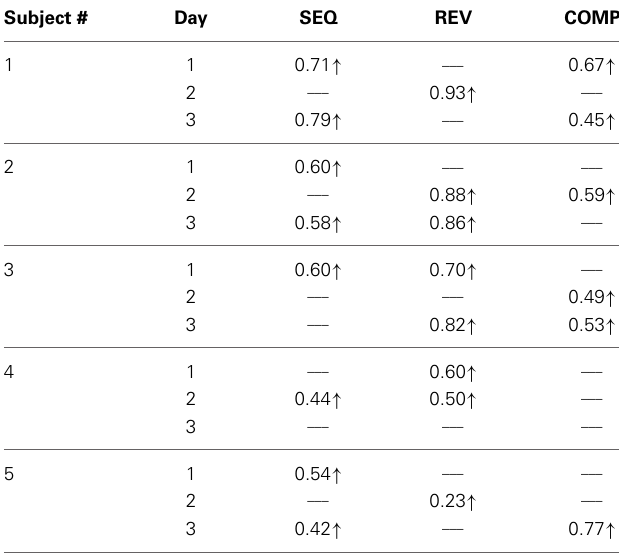
Table 2 | Coefficients of determination for the correlation between individual amount of M1-L activation and trial mean